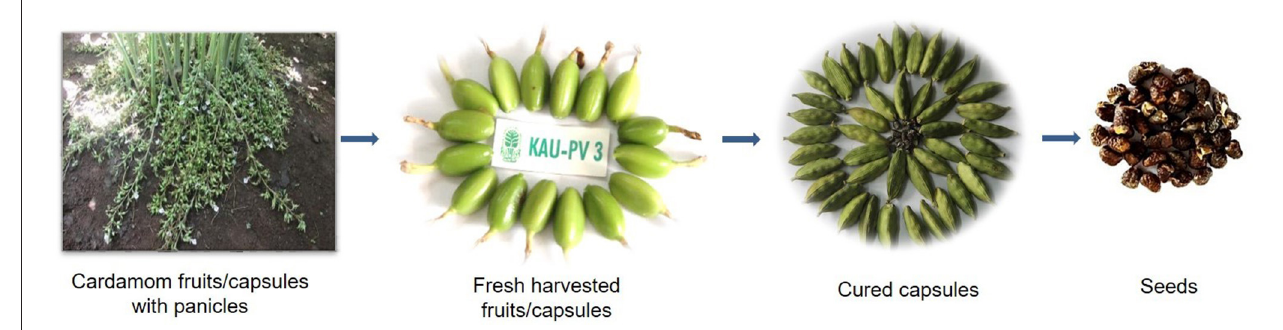
FIGURE 1 | Diagrammatic representation of usable of parts of cardamom.